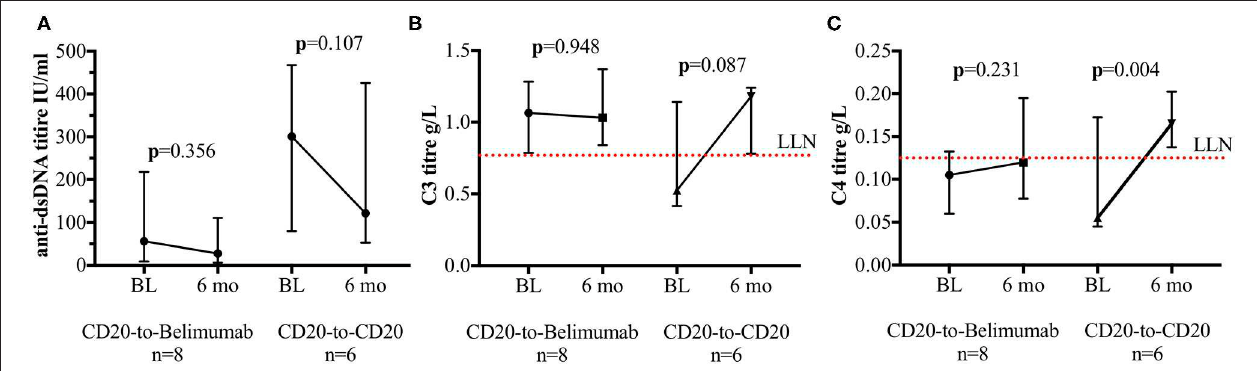
FIGURE 2 | Anti-dsDNA titres and complement levels. Immunological tests for the CD20-to-belimumab and the CD20-to-CD20 groups. Each figure shows the pre- and post-treatment for the (A) anti-dsDNA titres; (B) complement C3 level and (C) complement C4 level. Points represent median and error bars denote interquartile range. The dotted red lines represent lower limit of the normal values of the tests. BL, Baseline; 6 mo, 6